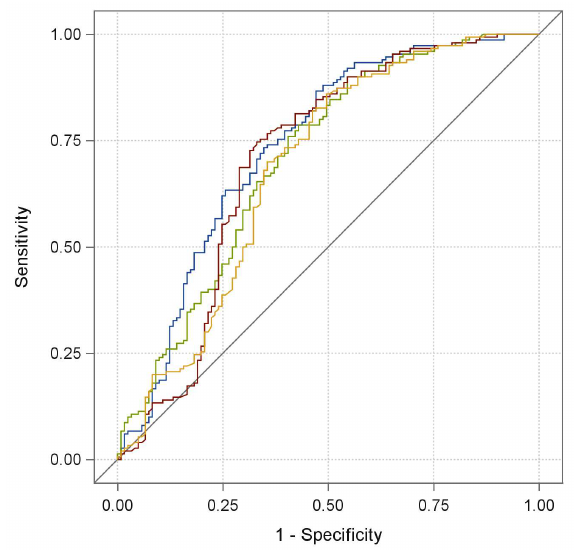
Figure 2. Receive Operating Characteristic (ROC) curves in the training set of the final multivariate model (blue line, Area under the ROC curve (AUC): 0.771), final model without performance status (green line, AUC: 0.749), final model without age (red line, AUC: 0.728), and LDH normalized univariate model (yellow line, AUC: 0.713).